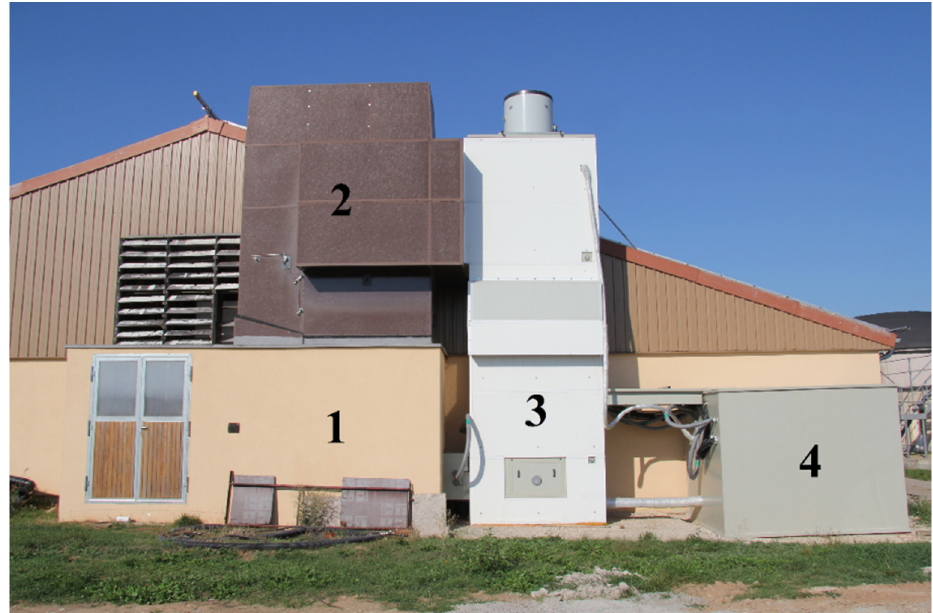
Figure 1. External view of the exchange scrubber pilot plant. Part of the exhaust air is drawn from the vacuum chamber ( 1 ) below the conventional heat exchanger ( 2 ) into the pilot plant ( 3 ). To the right of the test pilot plant is the equipment container ( 4 ), which housed the scrubbing water basin, the exhaust air treatment technology and its controls, as well as all measuring technology.